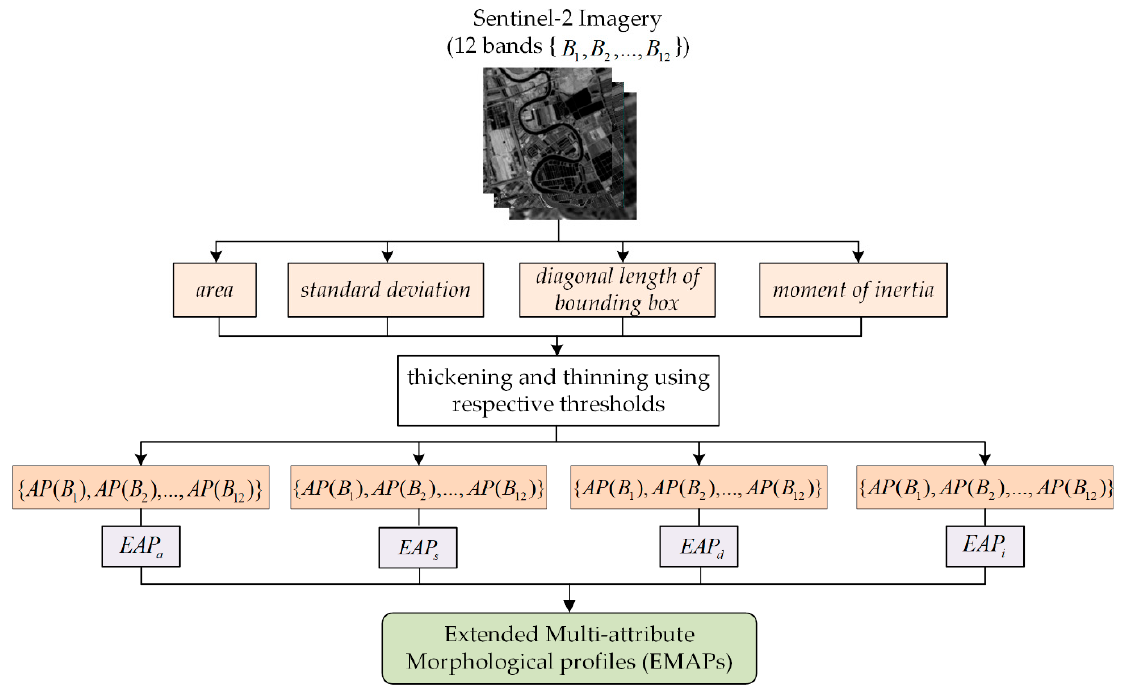
Figure 2. General scheme of constructing an extended attribute profile (EAP) from Sentinel-2 imagery. The extended multi-attribute profile (EMAP) is a combination of EAPs generated with four different attributes.